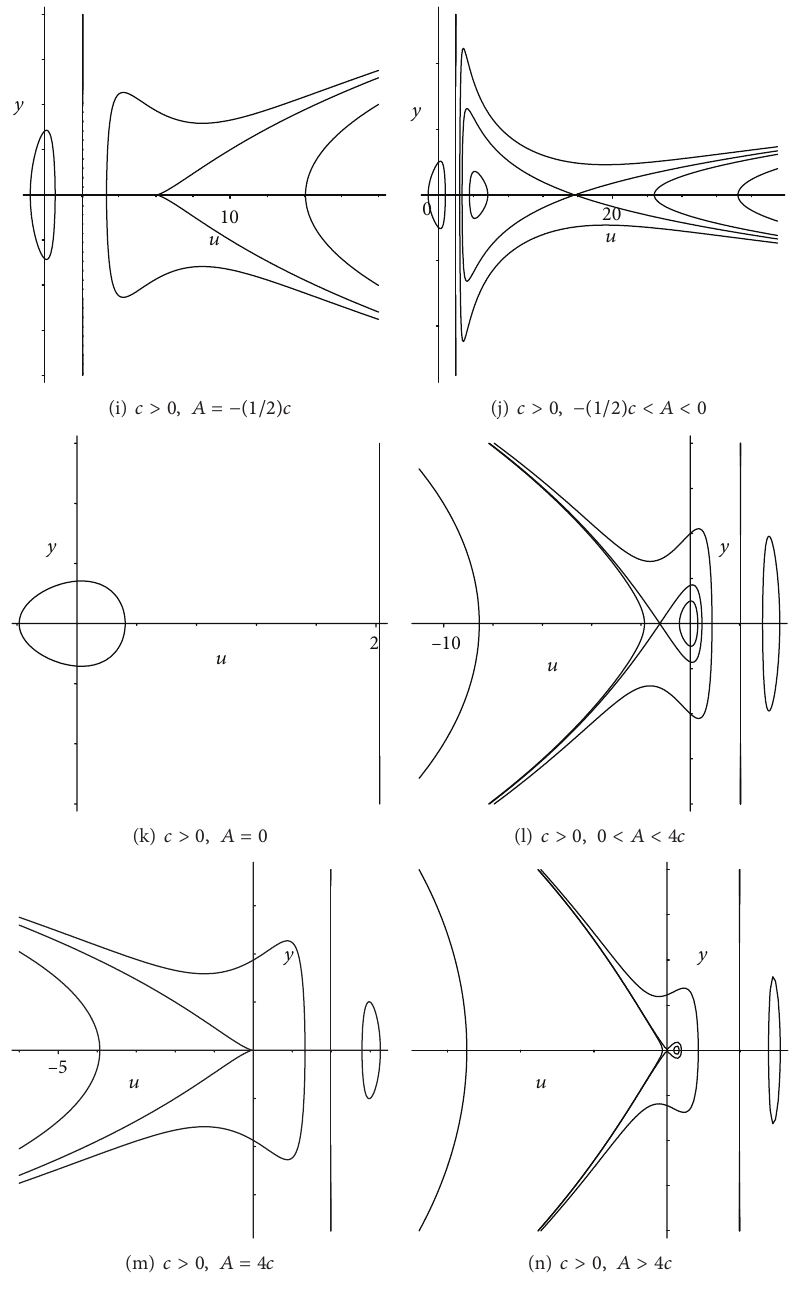
Figure 1: Bifurcation sets and phase portraits of system